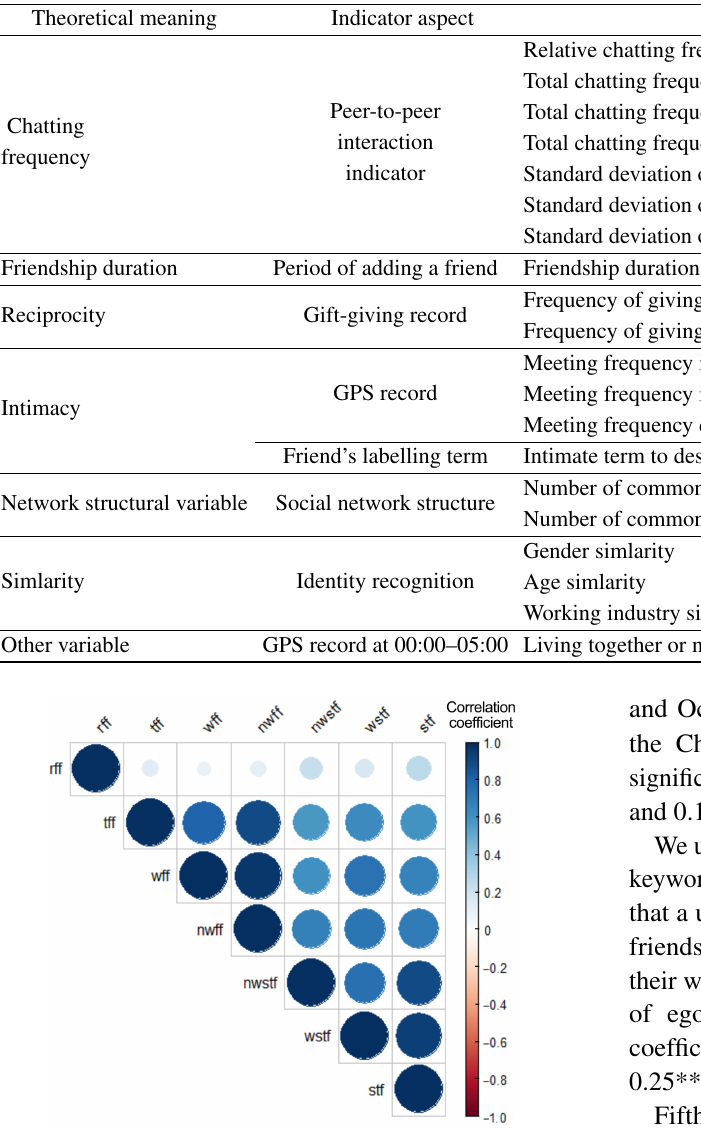
Fig. 2 Correlation diagram of online interaction